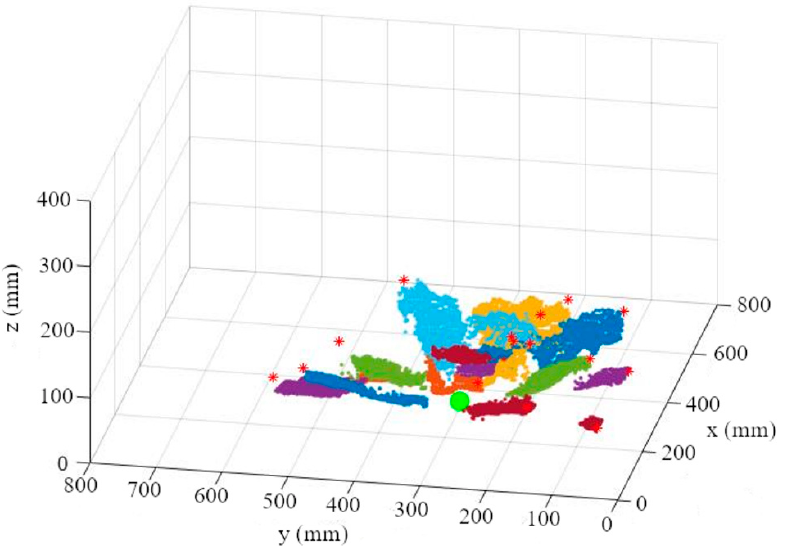
Figure 6. Leaf point cloud with marked leaf-attachment point (big green point) and leaf end-points